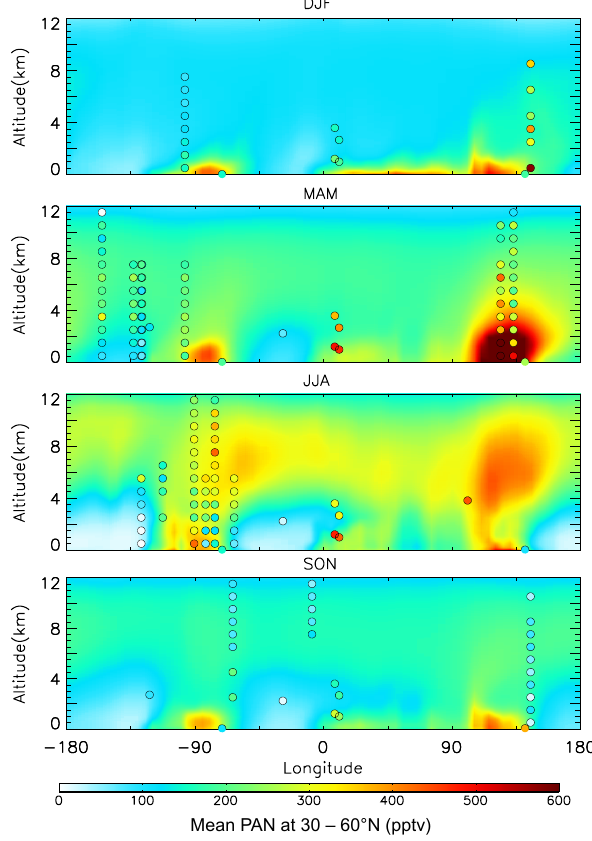
Fig. 3. Longitudinal cross-section of seasonal mean PAN concentra- tions at northern midlatitudes (30–60 ◦ N) as a function of altitude. Model results for 2008 (background solid contours) are compared to observations from many years in Table 2 (filled circles). Circles are placed at the mean longitude of the coherent regions (Fig. 2) that fall between (30–60 ◦